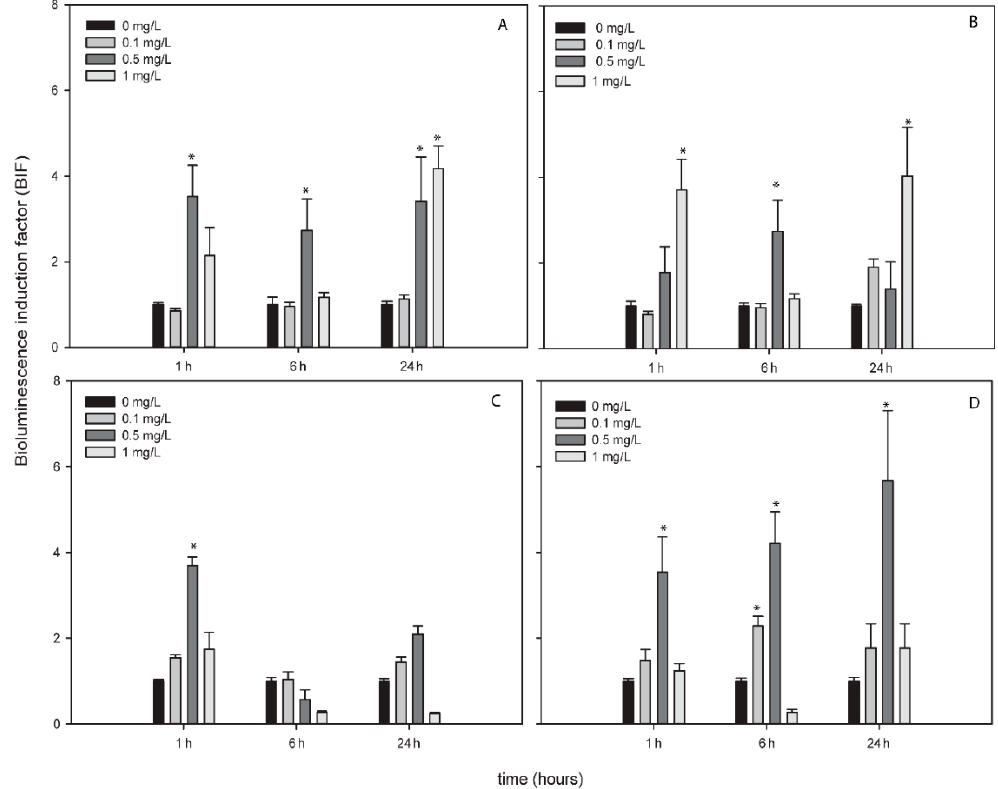
Figure 2. Bioluminescence induction of ROS-detecting Nostoc sp. PCC7120 bioreporters exposed to 0, 0.1, 0.5 and 1 mg / L of AgNPs after 1, 6 and 24 h of exposure. ( A ) Nostoc sp. PCC7120 pBG2154, ( B ) Nostoc sp. PCC7120 pBG2165, ( C ) Nostoc sp. PCC7120 pBG2172 and ( D ) Nostoc sp. PCC7120 pBG2173. The asterisks indicate statistically significant differences with respect to the control (unexposed cells) (ANOVA p < 0.05).